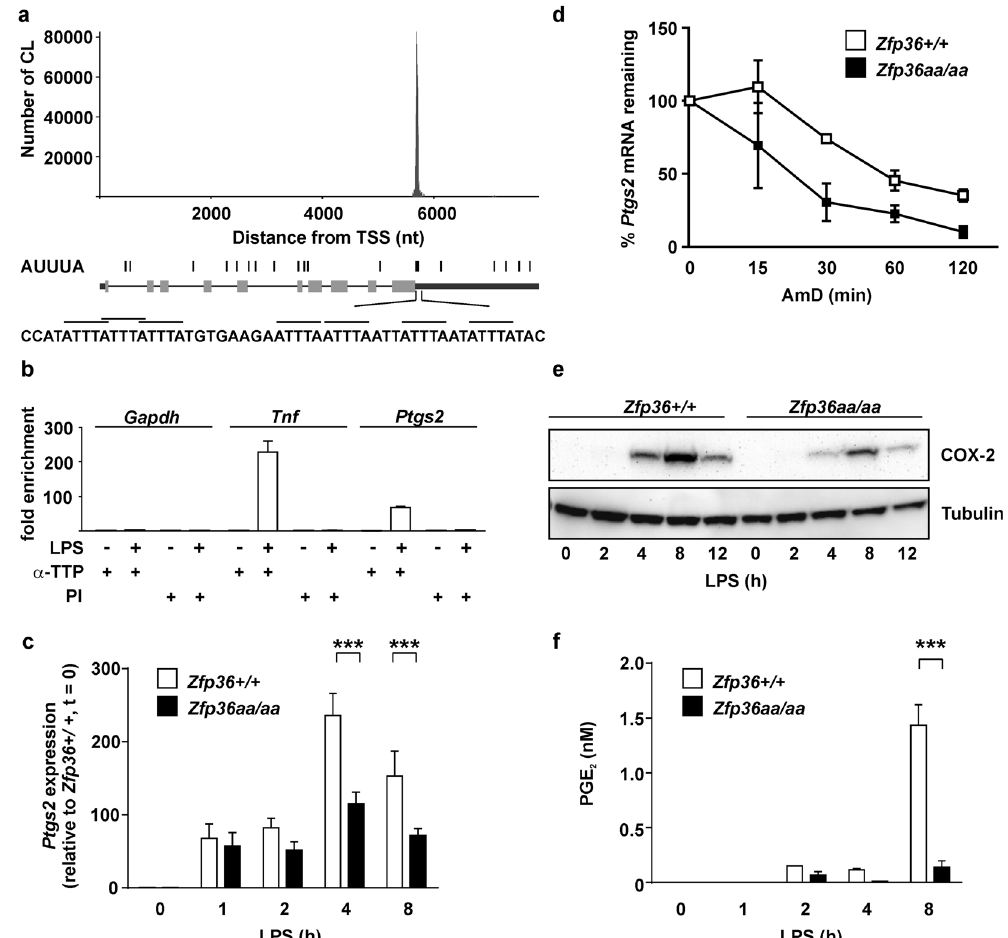
Figure 1. Ptgs2 gene expression is negatively regulated by tristetraprolin. ( a ) Number of TTP crosslinks (CL) is plotted against position on the Ptgs2 primary transcript. The primary transcript is illustrated below the graph, with coding exonic sequences as grey bars and non-coding exonic sequences as black bars. Positions of AUUUA motifs are represented above the transcript, and the sequence immediately 3 ′ to the stop codon is expanded below. Figure adapted from TTP-atlas data (http://ttp-atlas.univie.ac.at) 35 . ( b ) RNA immunoprecipitation was performed on whole cell lysates of RAW264.7 cells, untreated or stimulated with LPS for 2 h, using a TTP antiserum or pre-immune control (PI). Gapdh , Tnf and Ptgs2 mRNAs were measured by quantitiative PCR, and fold enrichment was calculated relative to the PI control. A representative of three similar experiments is shown. Error bars indicate SD of triplicate measurements. ( c ) Zfp36 + / + and Zfp36aa / aa BMMs were stimulated with 10 ng/ml LPS for the times indicated, and Ptgs2 mRNA was measured by qPCR. The graph represents mean ± SEM of three independent BMM cultures of each genotype. *** p < 0.005; Holm-Sidak method for multiple comparison. ( d ) Zfp36 + / + and Zfp36aa / aa BMMs were stimulated with 10 ng/ml LPS for 4 h then actinomycin D was added and Ptgs2 mRNA measured by qPCR at the intervals indicated. The graph shows mean ± SEM of three independent BMM cultures of each genotype. ( e ) Zfp36 + / + and Zfp36aa / aa BMMs were stimulated with LPS for the times indicated and COX-2 protein was detected by western blotting. Representative of three repeats. ( f ) Zfp36 + / + and Zfp36aa / aa BMMs were stimulated with LPS for the times indicated and PGE 2 in the tissue culture supernatant was measured by ELISA. The graph represents mean ± SEM of three independent BMM cultures of each genotype. *** p < 0.005; Holm-Sidak method for multiple